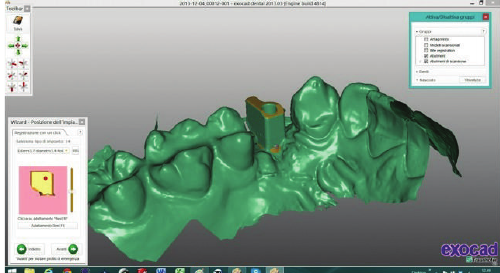
Figure 10: The scanned images were processed with Exocad Den- talCAD platform.